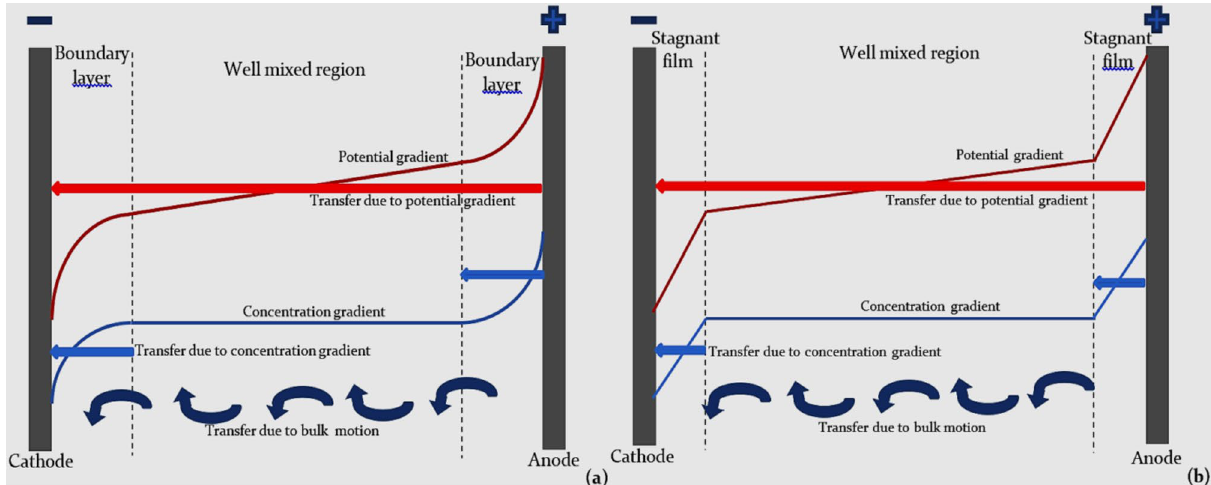
Fig. 1 Gradients and mass transfer contributions for the species reducing at cathode: a according to boundary layer approach, b according to stagnant film (Nernst diffusion layer)